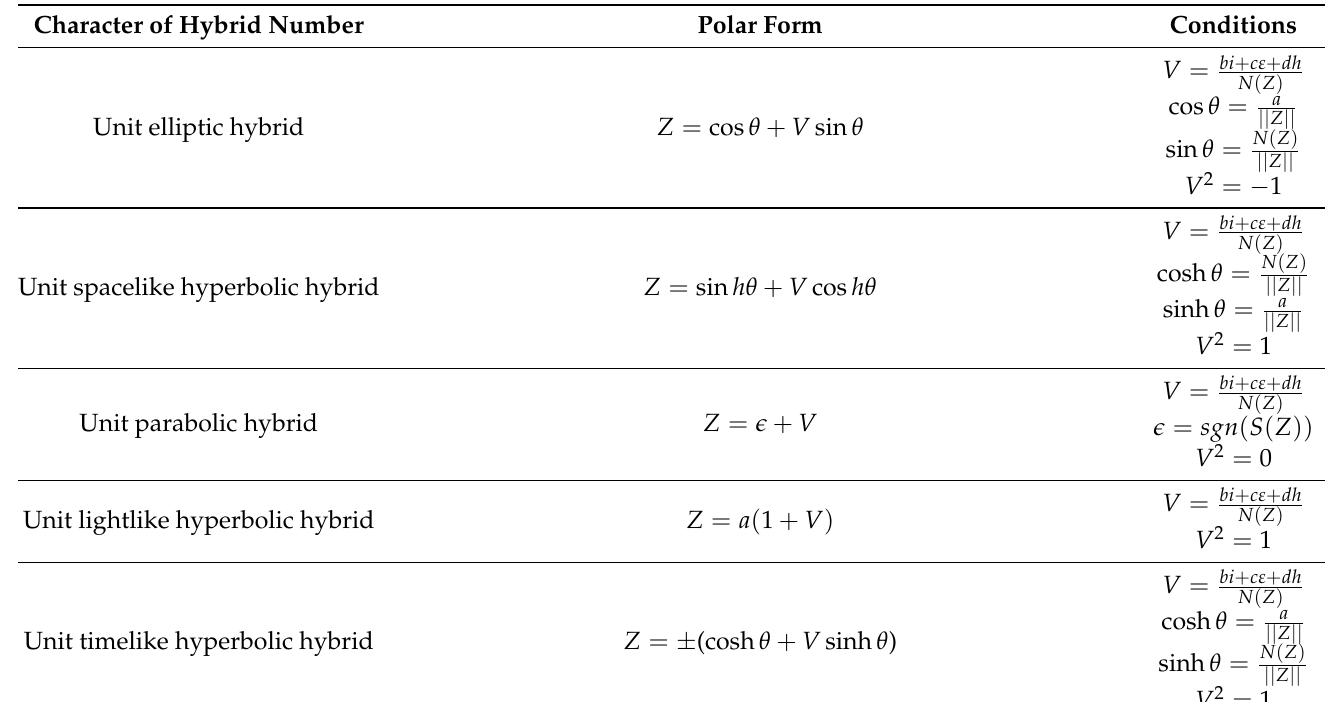
Table 1. The polar representations of the hybrid